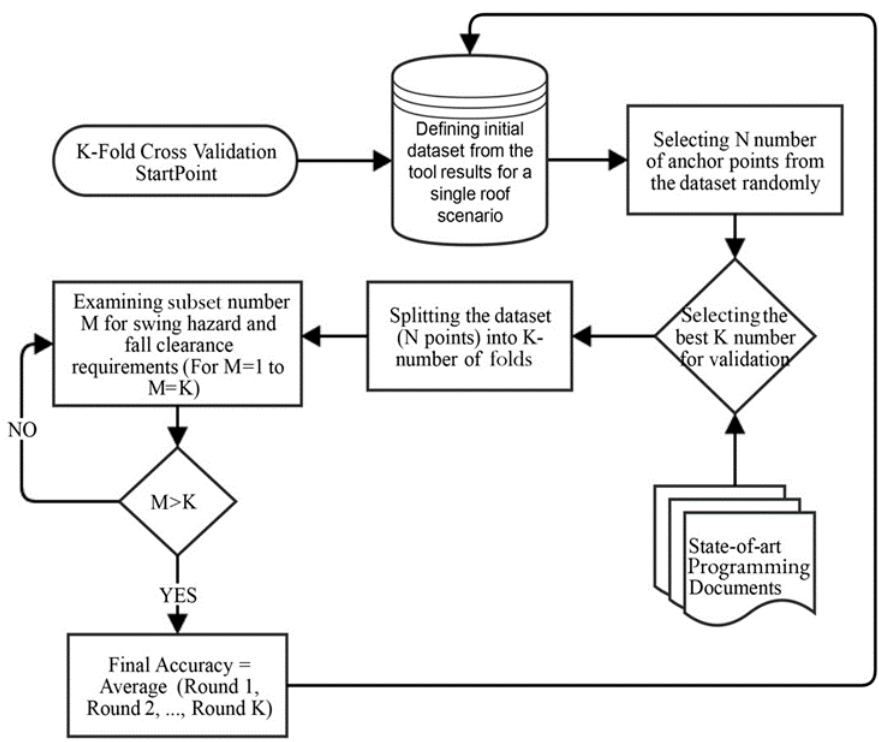
Figure 11. K-fold Cross-Validation Model used in this research.